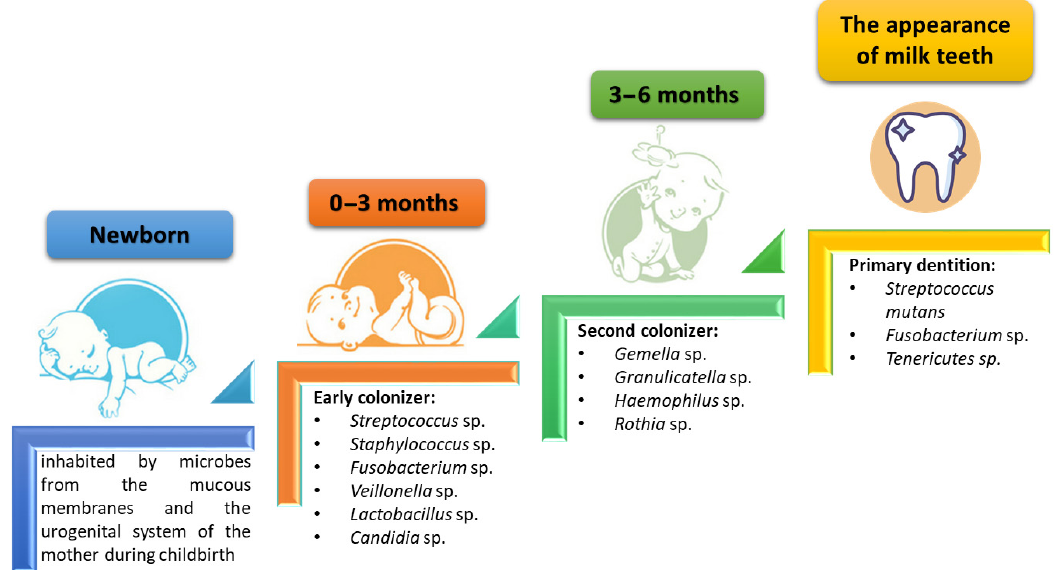
Figure 1. Changes in the composition of the oral microbiota during childhood development (based on